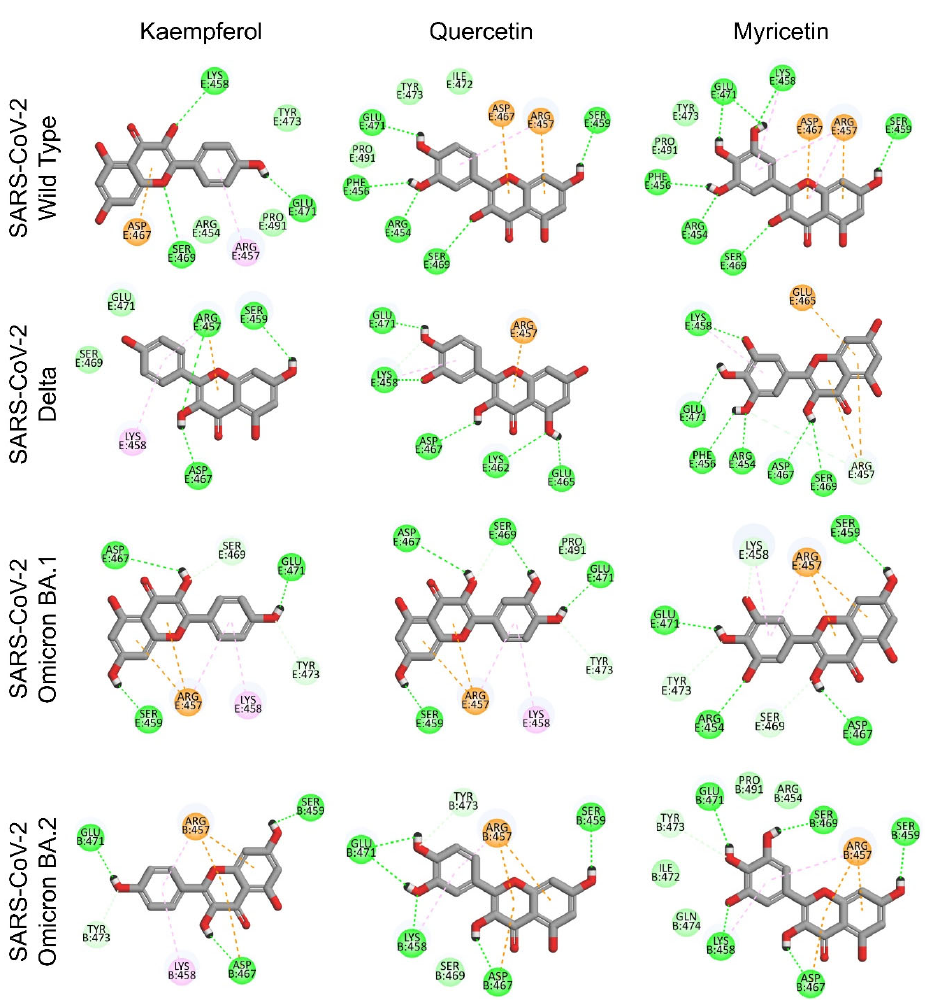
Figure 6. Molecular models of flavonols binding to the Pocket 3 in spike RBD from different mutant strains.